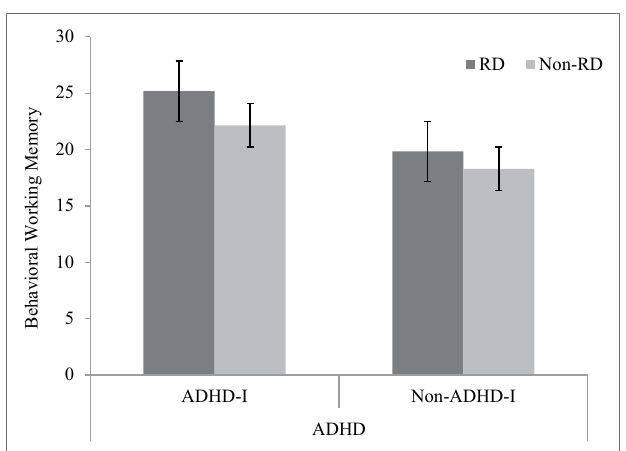
FIGURE 1 | Interaction effect of ADHD-I and RD in behavioral working memory.